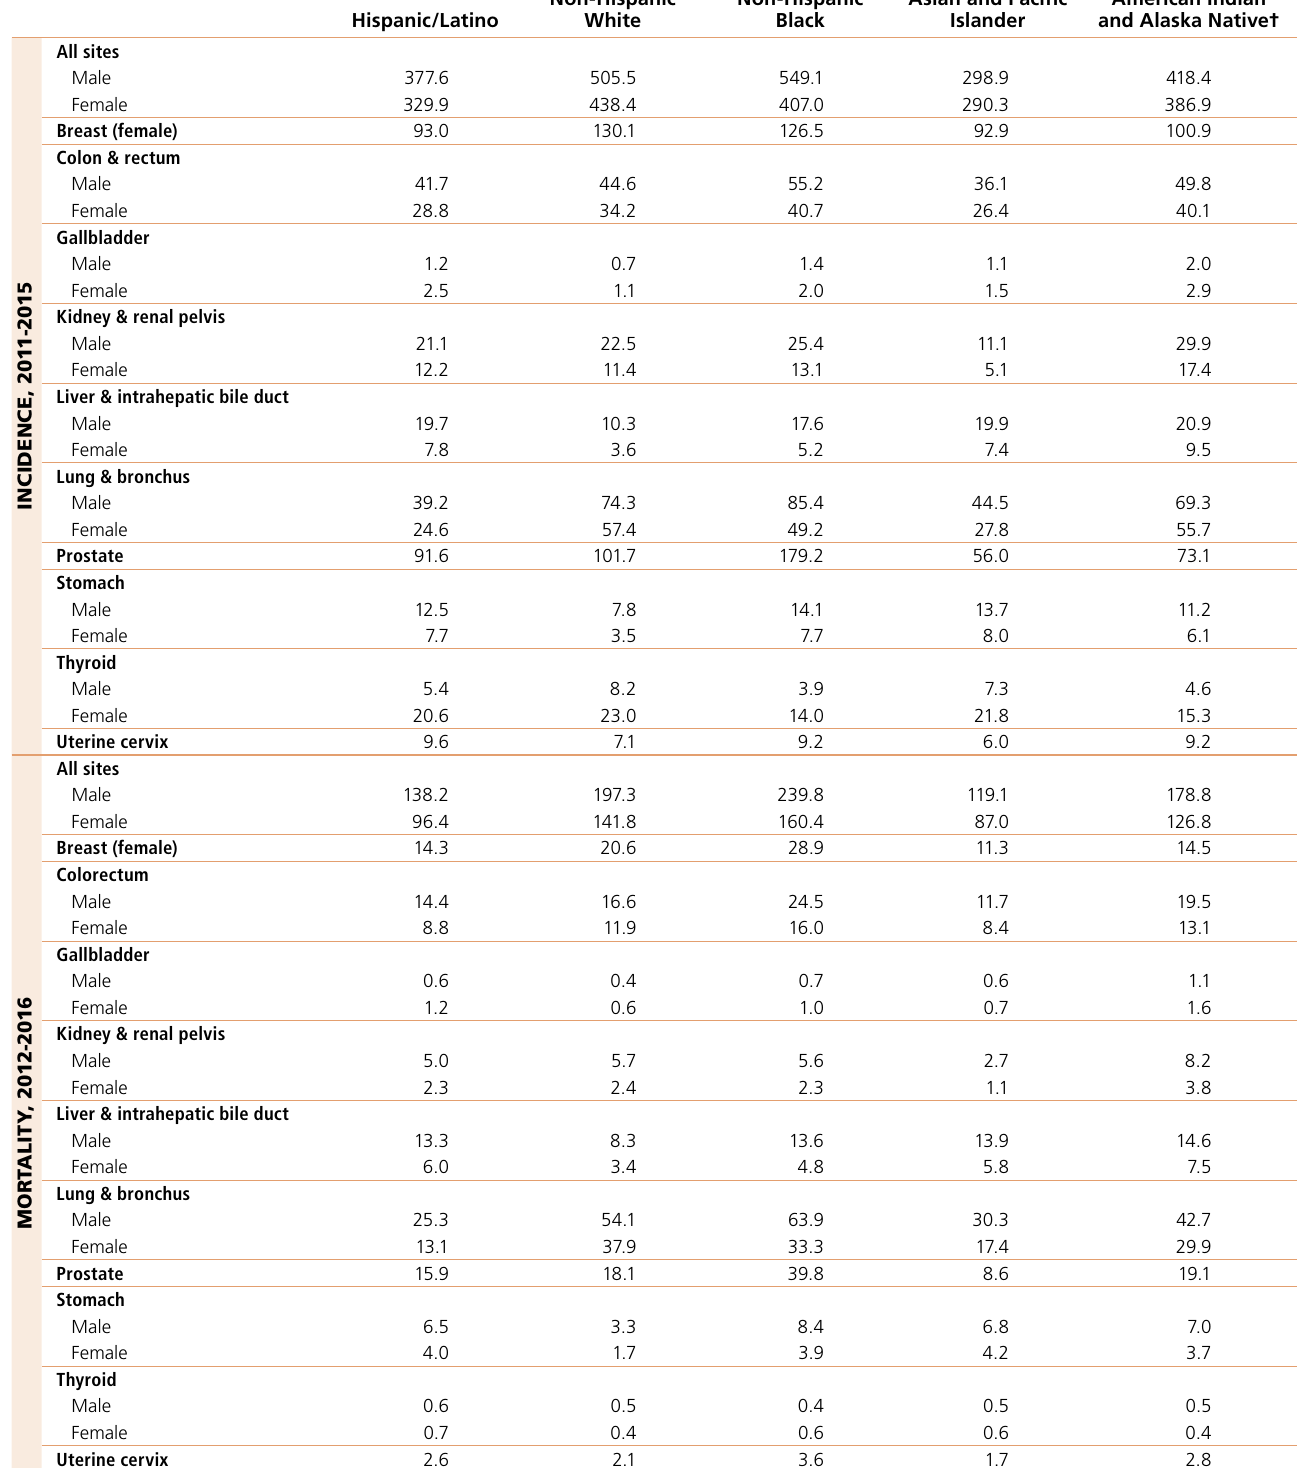
Table 3. Incidence and Mortality Rates* for Selected Cancers by Race and Ethnicity, US, 2011-2016